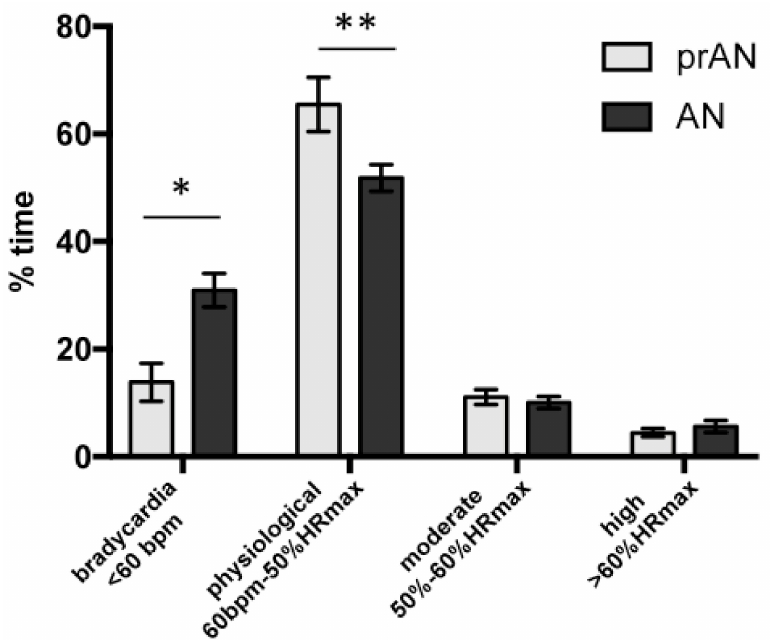
Figure 1. Data obtained from 72 h cardiovascular recording allowing to determine the percentage of time spent in bradycardia, physiological, moderate and high physical activity in patients with acute anorexia nervosa (aAN, n = 55) and partially recovered AN (prAN, n = 13). bpm: beat per minute; HRmax: maximum heart rate (220-age). * p < 0.05; ** p <